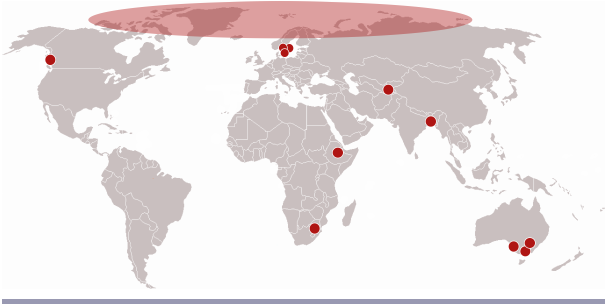
Fig. 1 . Cases of resilience practice included in this study. The Arctic case covers a much larger area compared to the others, which are on a local-regional scale. Apart from the Arctic, included countries are: Australia, Bangladesh, Canada, Ethiopia, South Africa, Sweden, and Tajikistan.